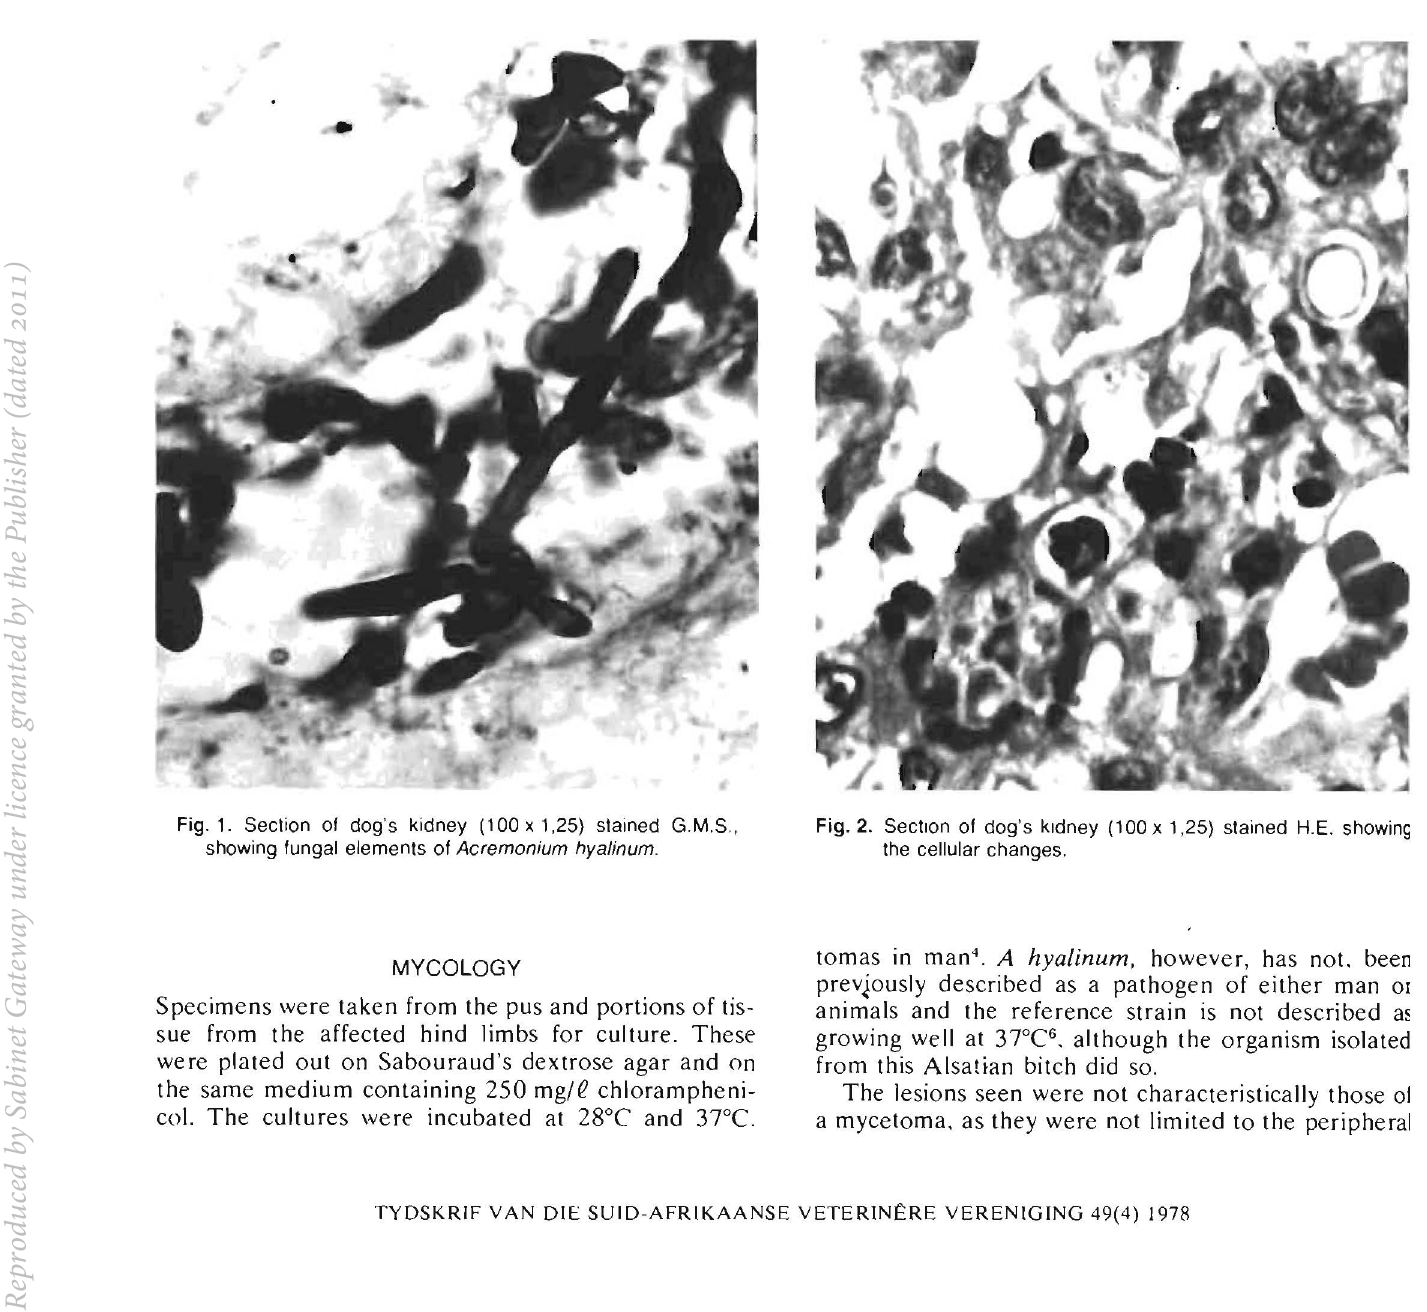
Fig. 1. Seclion of dog's kidney (100 x 1,25) stained G.M.S, showing fungal elements of Acremonium hya/inum.